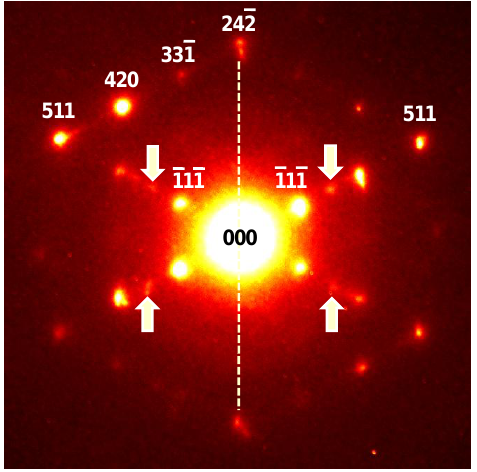
bulk heterojunction layer. 60